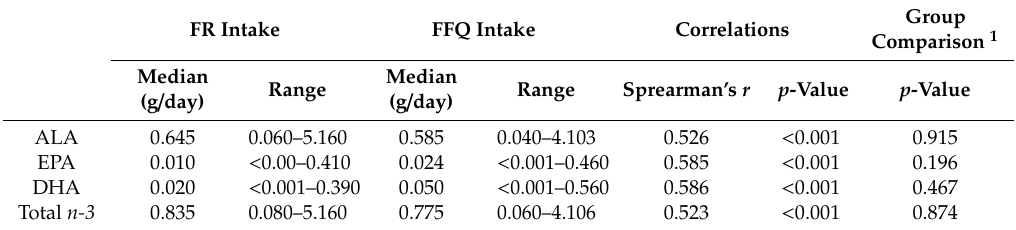
Table 2. Median n-3 PUFA intake assessed using 7-day weighed food records (FR) and food frequency questionnaires (FFQ), correlations between n-3 PUFA intake estimated by FR and FFQ and group comparisons of n-3 PUFA intakes between FR and FFQ ( n =